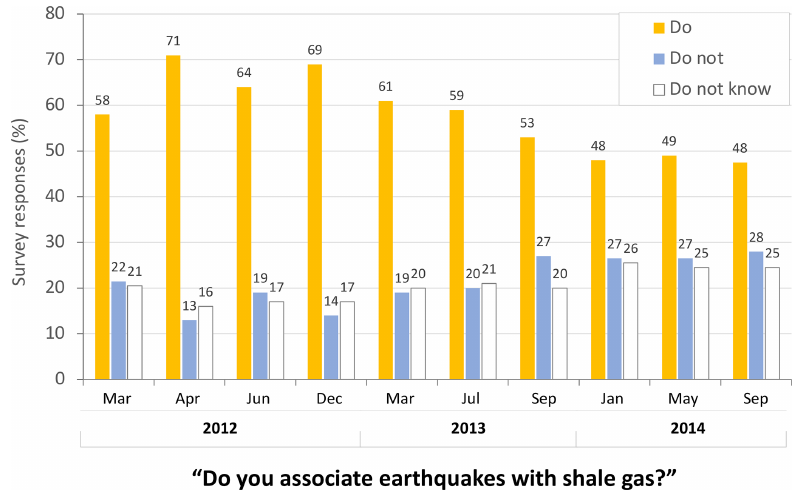
Figure 2. Responses to the 10 University of Nottingham surveys administered between 2012–2014 via YouGov to assess public perspectives on shale gas development (O’Hara et al., 2016). During the period 2012–2014, the number of participants that associate shale gas with earthquakes decreases, while the number of participants that do not associate shale gas with earthquakes or do not know increases. Results from the additional two surveys administered between 2014–2016 are not publicly